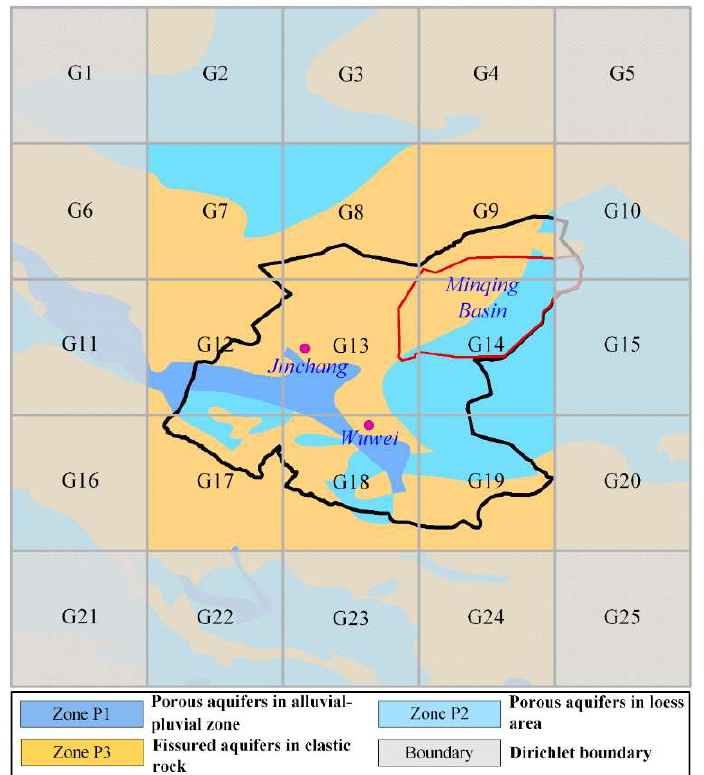
Figure 3. Distribution of parameter zones and Dirichlet boundaries in the study area.